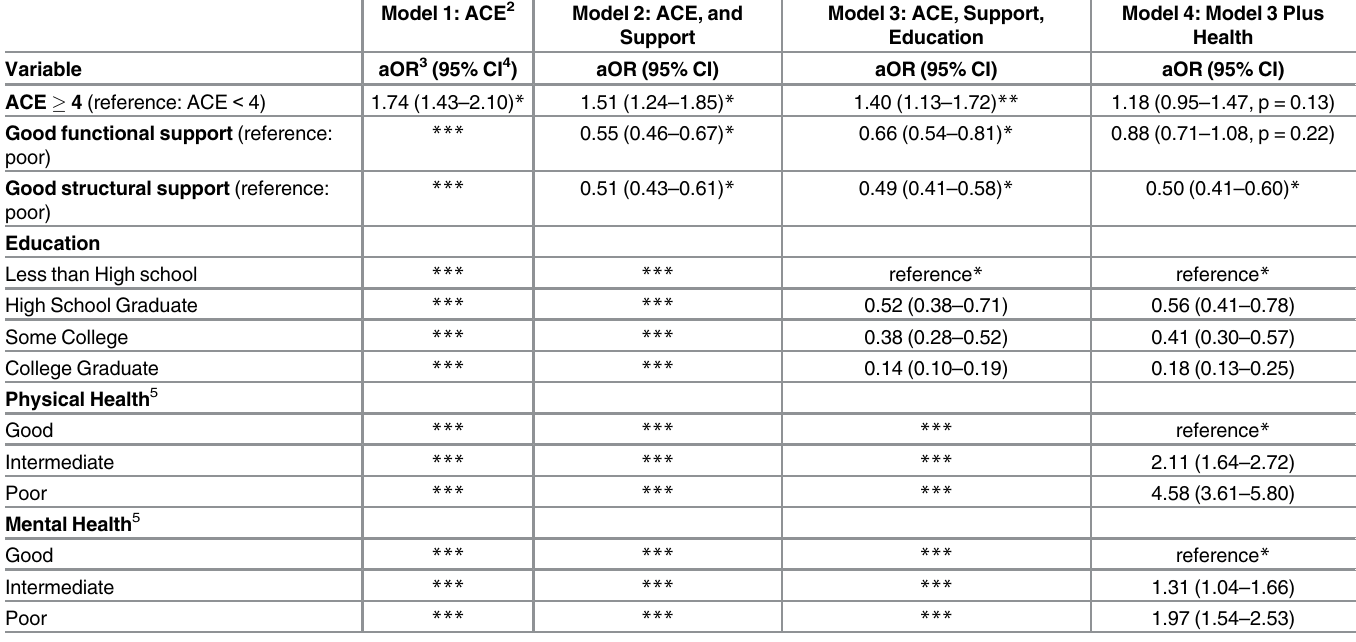
Table 5. Multivariate Logistic Regression 1 Analyses of Odds of Inability to